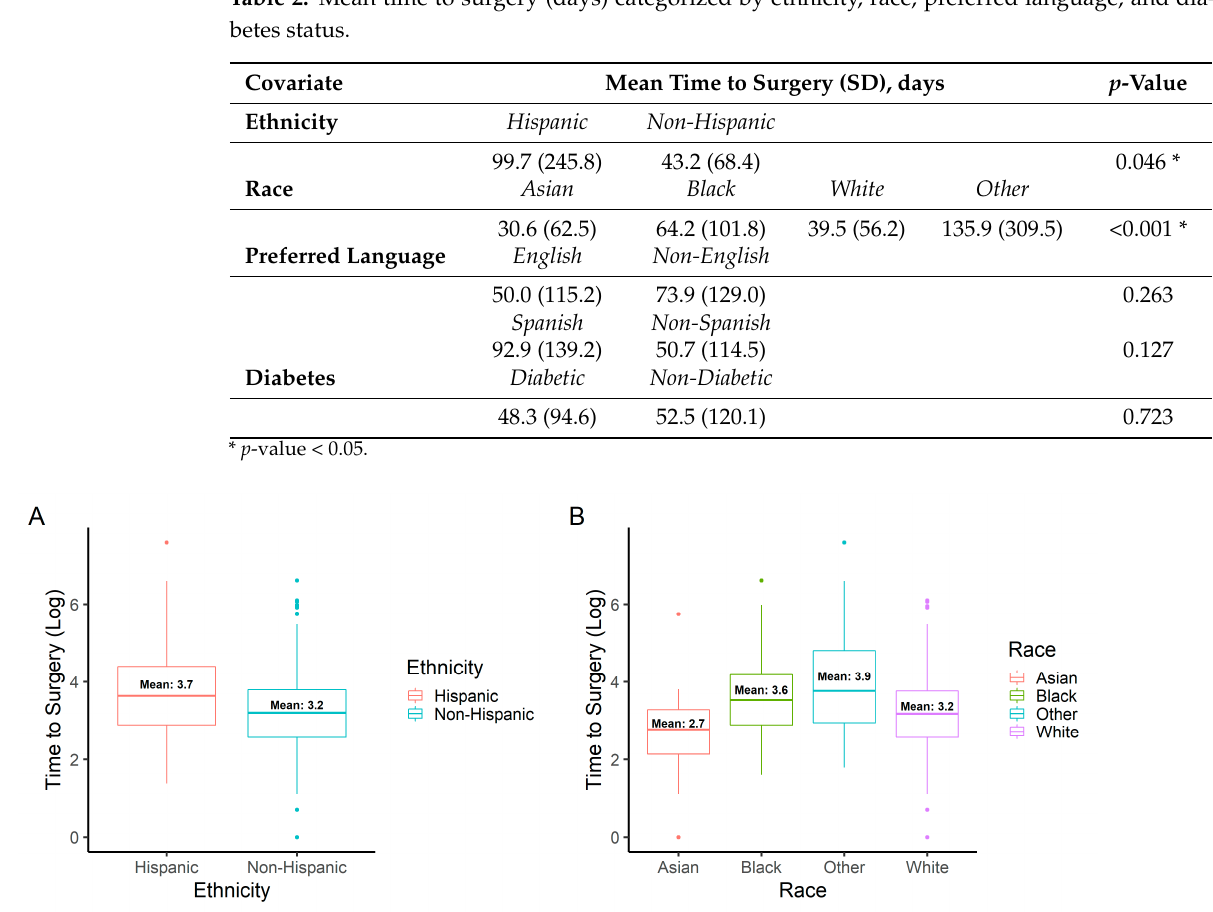
Figure 2. Logarithmic time to surgery distribution by ( A ) ethnicity (Hispanic or non-Hispanic) and ( B ) race (Asian, Black, White, or Other).